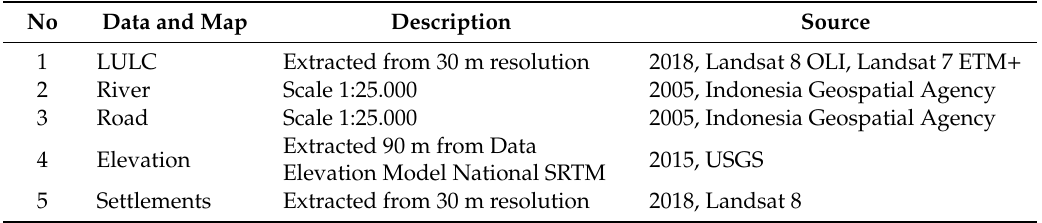
Table 1. Satellite and GIS datasets for land suitability analysis for extension of potential forest areas.